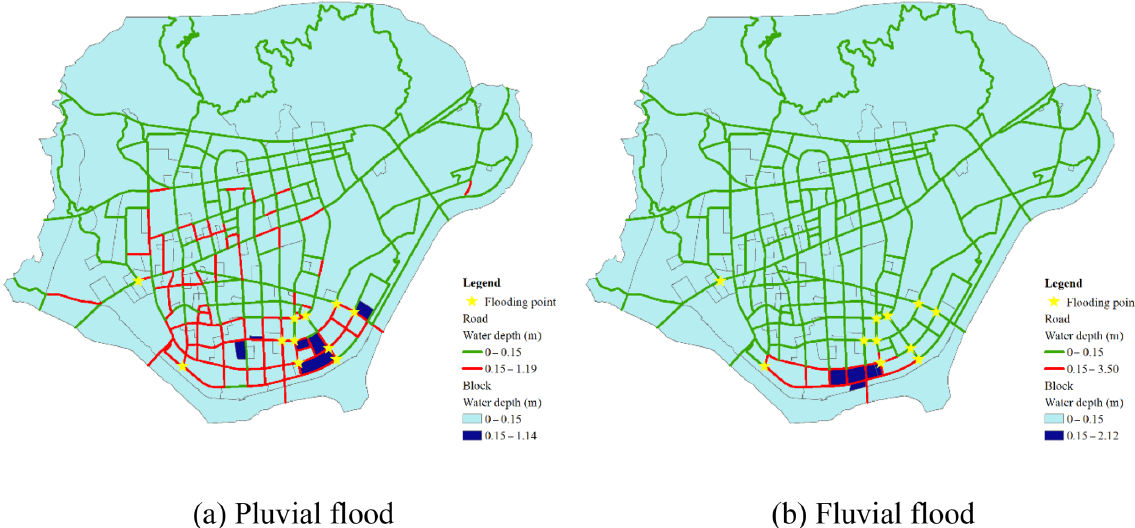
Figure 11. Map of the flooded area indicating the flooding simulation and the real flood in 2014. The information for the flooded area was provided by Lishui City Housing and Urban-Rural Construction